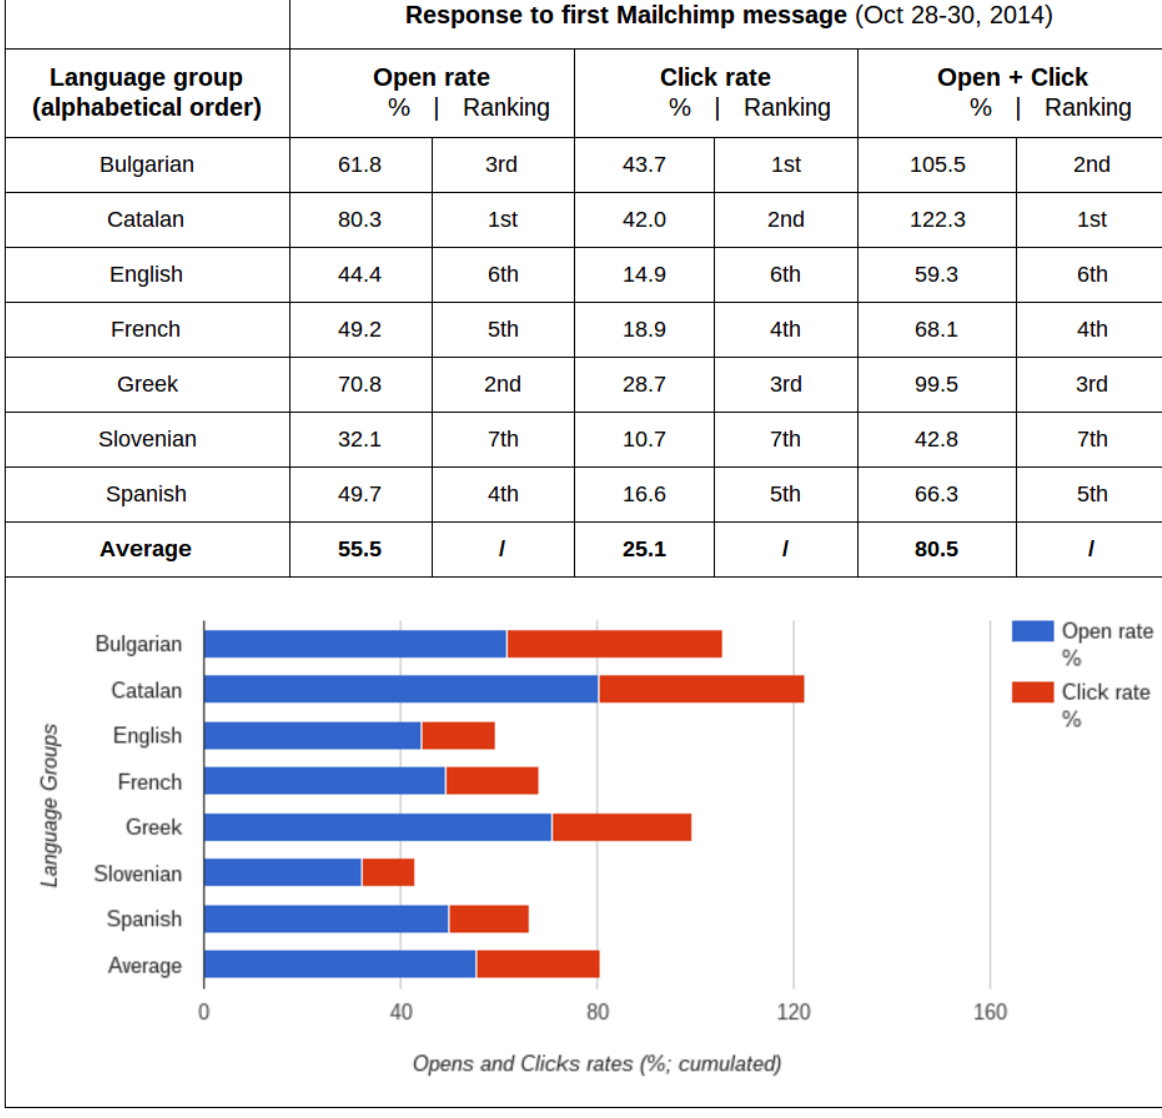
Figure 13 . Response to early Mailchimp campaign by the seven language